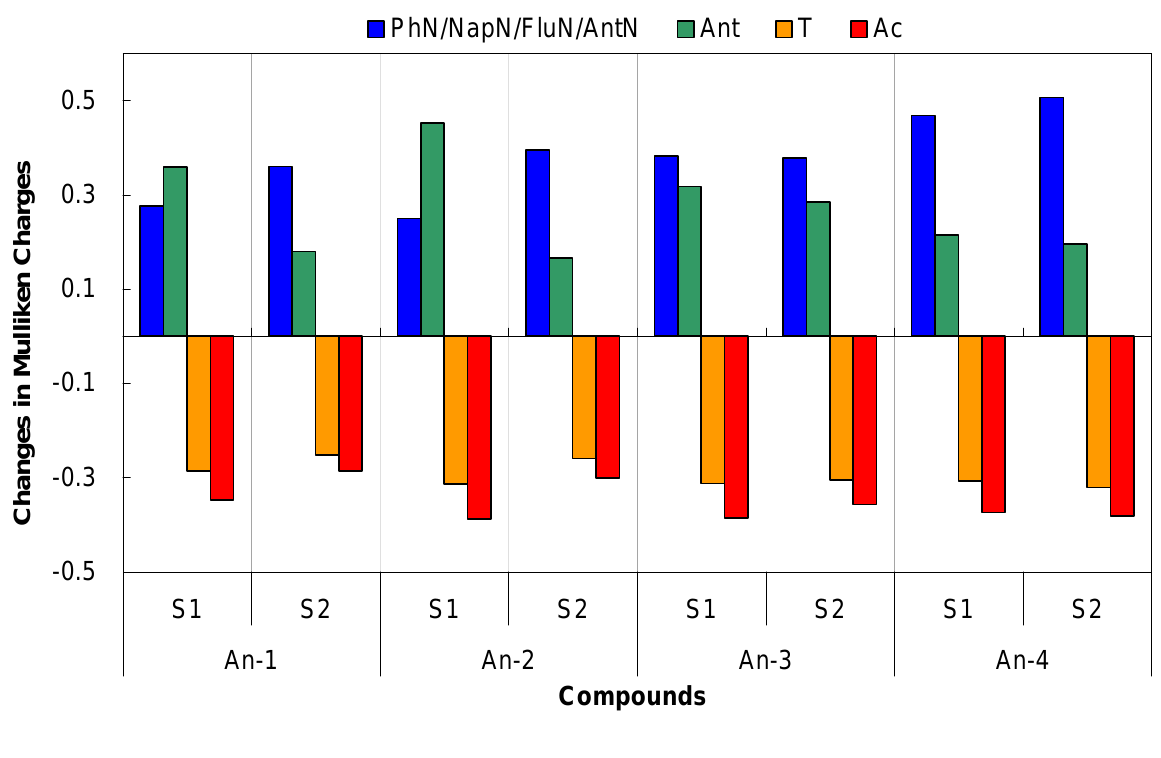
Figure 12. Plot of the difference in the Mulliken charges between the ground-state and the excited